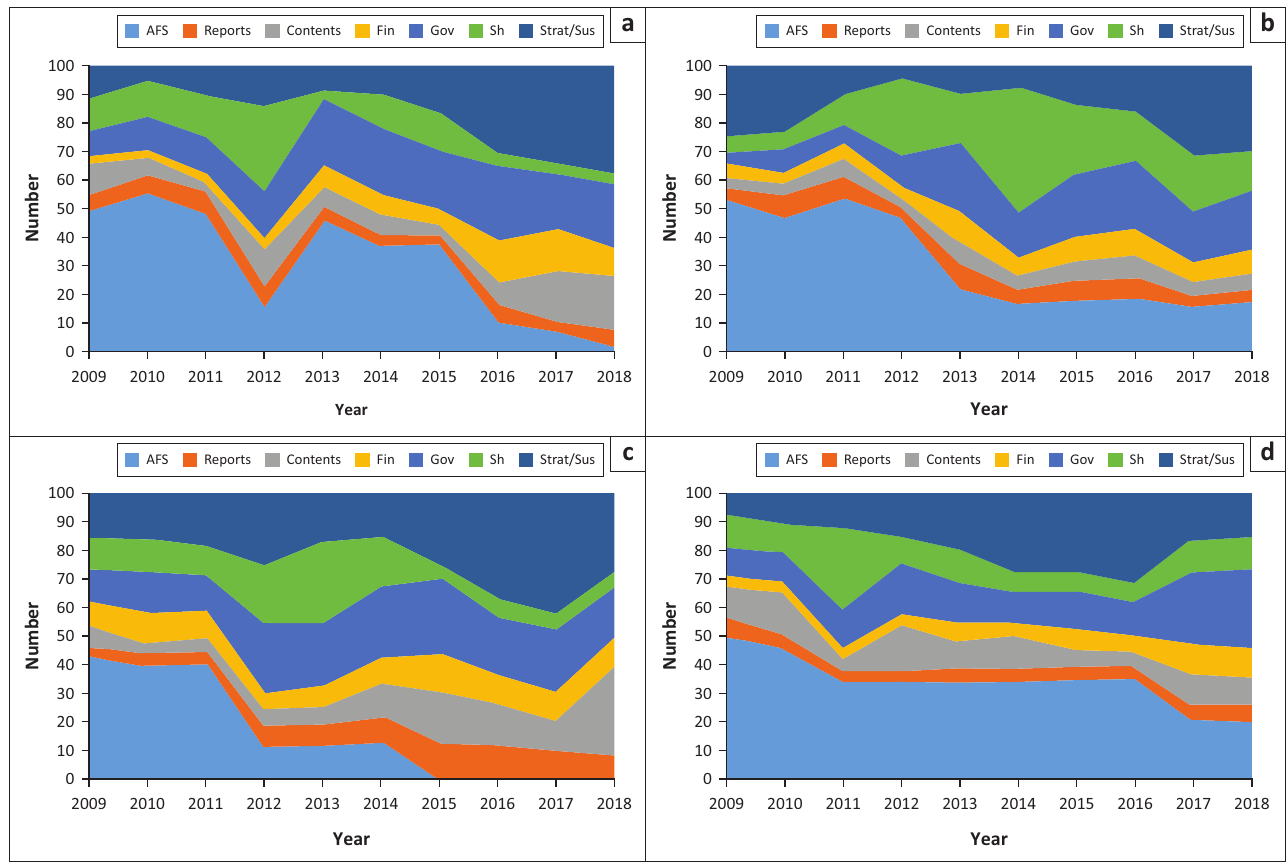
FIGURE 2: Graphical depiction of the composition of annual integrated reports (percentage of total pages): Pick n Pay, Shoprite, Spar and Clicks